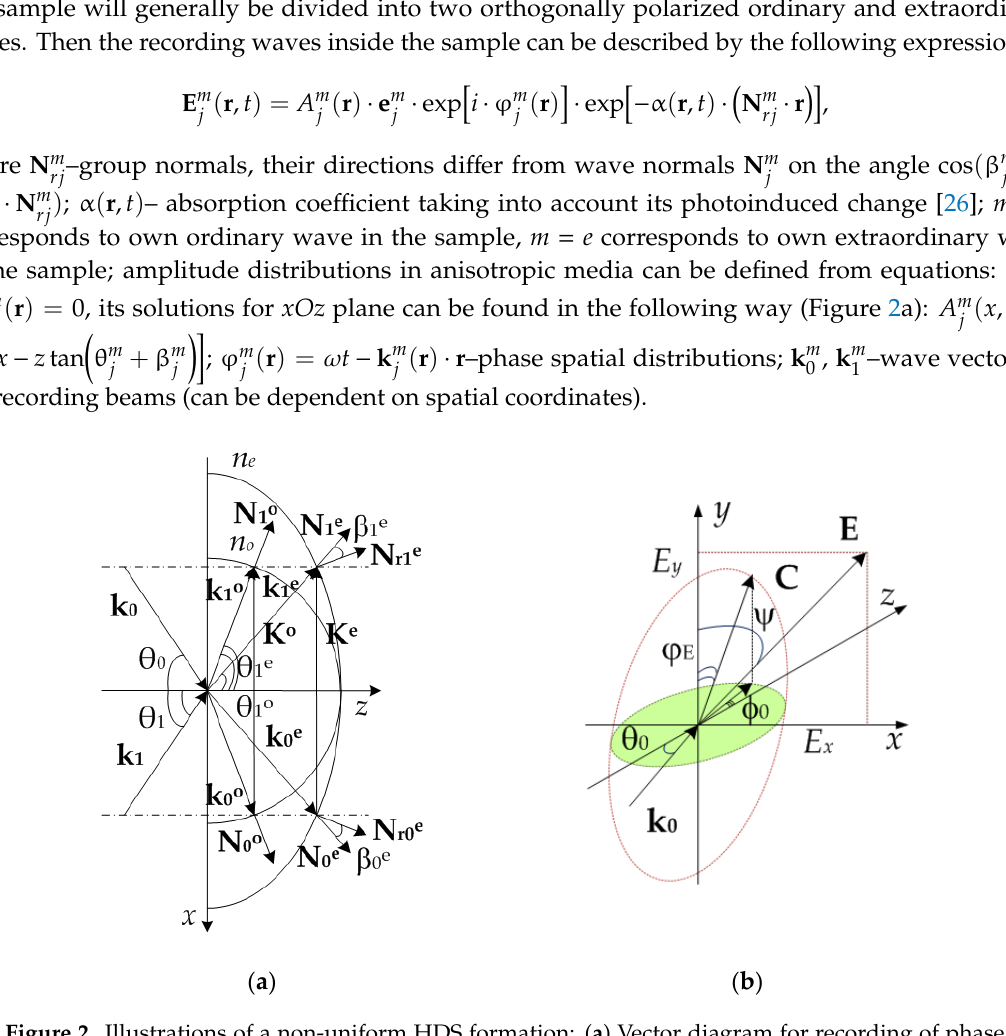
Figure 2. Illustrations of a non-uniform HDS formation: ( a ) Vector diagram for recording of phase diffraction gratings; ( b ) photo-induced Freedericksz transition.